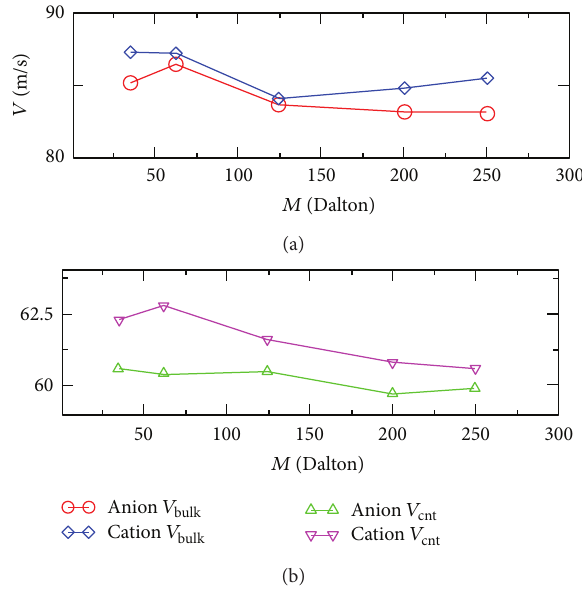
Figure 2: The flow velocities of the cation and anion depending on the different atomic masses of the anion, at an external pressure of 𝑃 ≈ 500 atm and at temperature 𝑇 = 300 K. (a) Flow velocities of the cation and the anion in bulk solution. (b) Flow velocities of the cation and the anion in a (76,0) carbon nanotube.